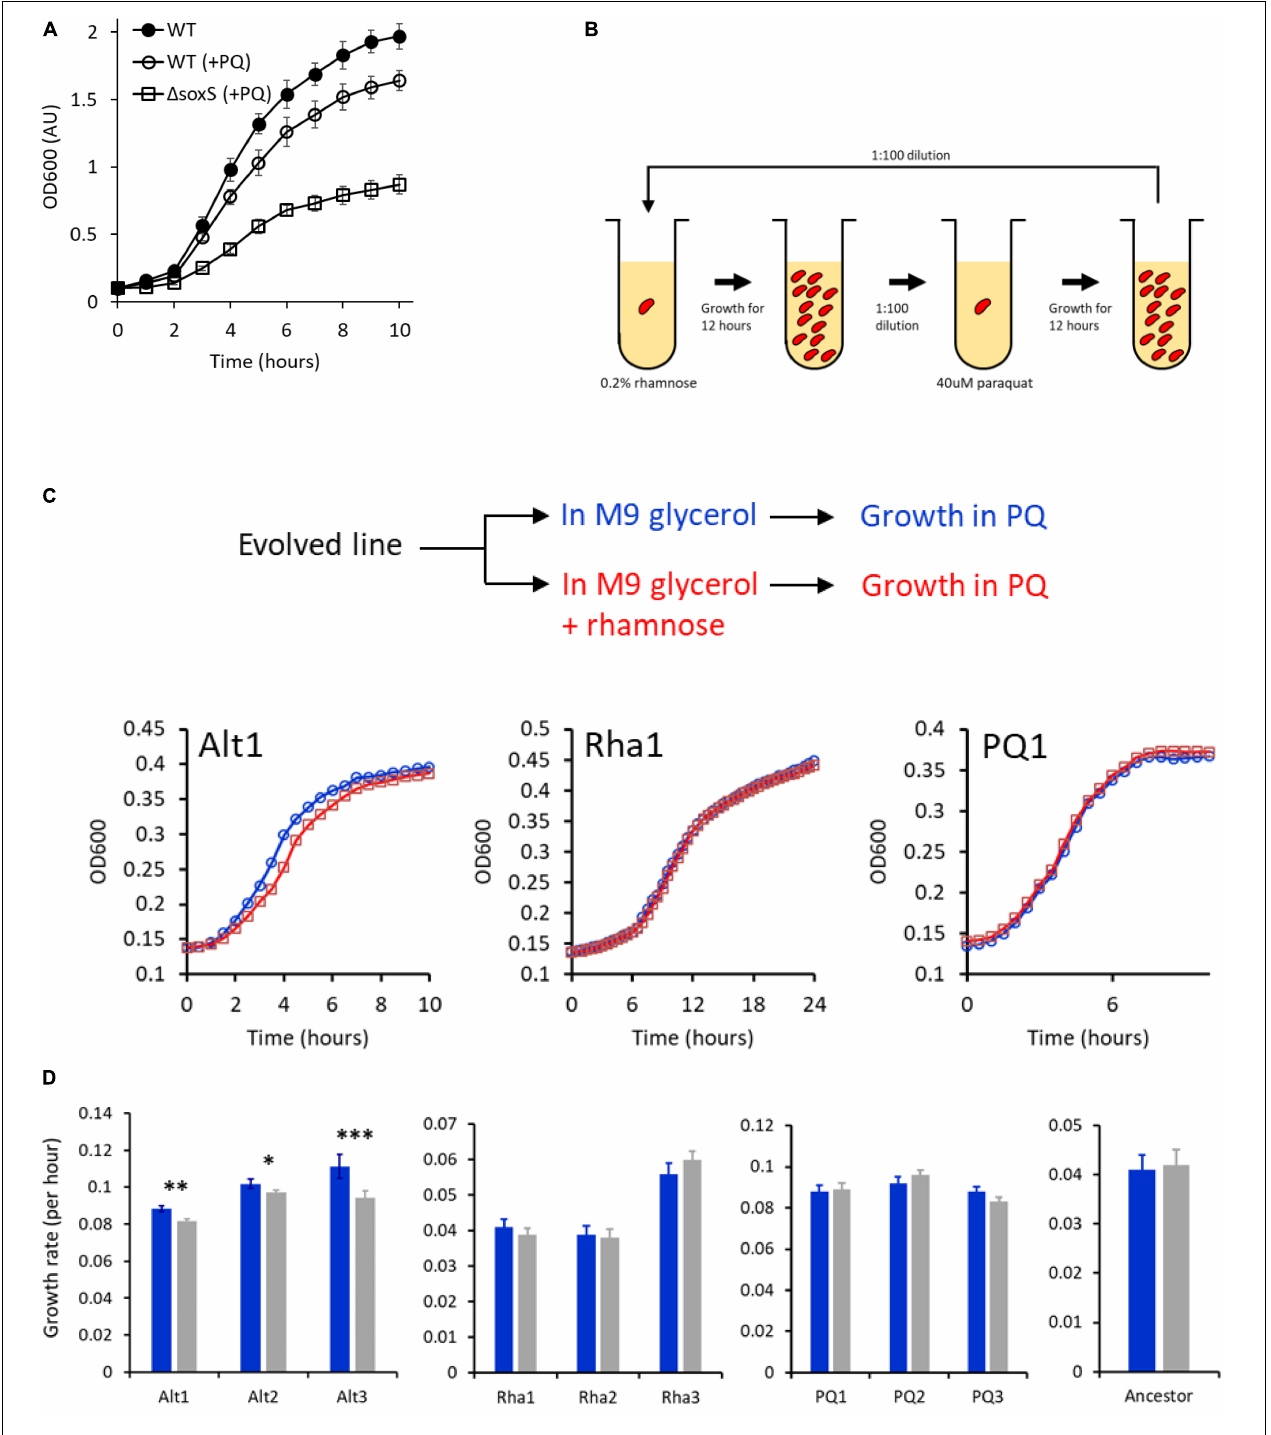
FIGURE 4 | (A) Escherichia coli exhibits a growth defect in M9 glycerol media, when grown in the presence of 40 µ M PQ. (B) Experimental plan for the rhamnose-PQ alternating evolution. Cells were exposed to rhamnose and then PQ for 6–7 generations for a total of 850 generations. (C) Anticipatory regulation evolves in rhamnose-PQ alternating lines. Cells from rhamnose-PQ evolved line (line Alt1) (left), rhamnose-only evolved line (line Rha1) (middle), and PQ-only evolved line (PQ1) (right) were grown in M9 minimal glycerol media with (blue) or without (red) rhamnose. The cells were transferred 1:100 to M9 glycerol media with 40 µ M PQ, and their growth kinetics observed. (lines 1 from alternating rhamnose-PQ; only rhamnose; and only PQ.) (D) Anticipatory regulation provides a growth advantage in all rhamnose-PQ alternating evolved lines. Growth rates of the evolved lines in M9 glycerol media containing 40 µ M PQ, when transferred from M9 glycerol media with (blue) or without (gray) 0.2% rhamnose. ( ∗∗∗ p -value < 0.01; ∗∗ p -value < 0.02; ∗ p -value < 0.15; two-tailed, paired t